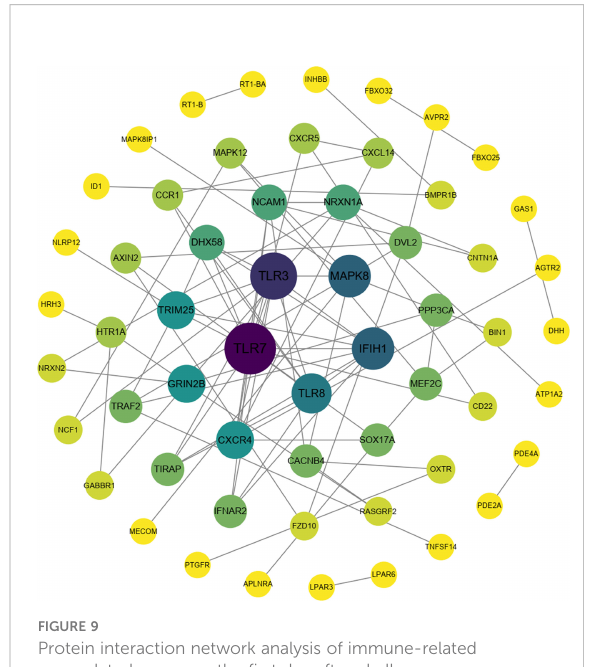
FIGURE 9 Protein interaction network analysis of immune-related upregulated genes on the fi rst day after challenge.